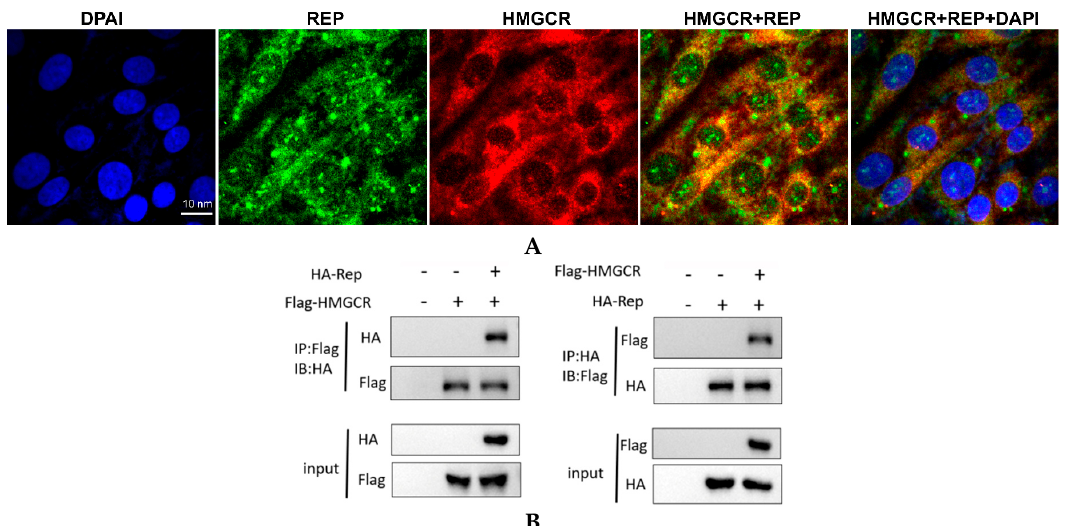
Figure 7. Interaction between HMGCR and PCV2 Rep protein. ( A ) Colocalization of HMGCR and PCV2 Rep protein. HMGCR (Cy3; red), PCV2 Rep protein (FITC; green), DAPI (blue) and overlap (yellow), scale bar: 10nm. ( B ) Co-IP of HMGCR and PCV2 Rep protein. Flag (HMGCR), HA (Rep).